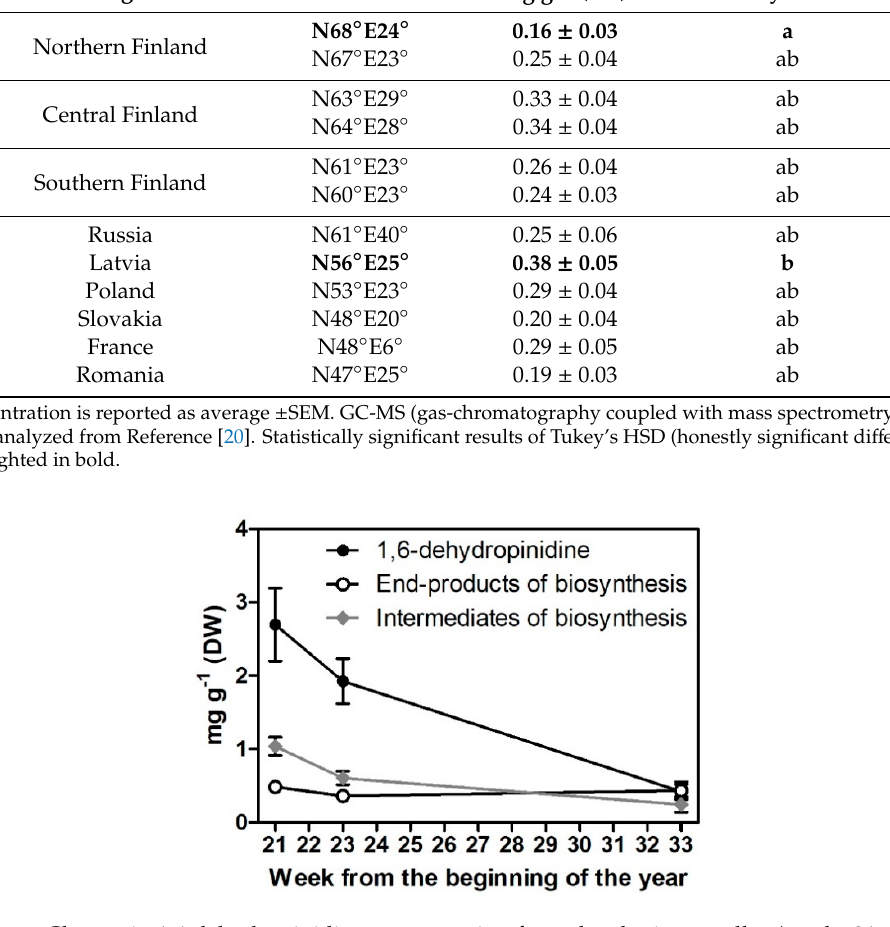
Figure 2. Change in 1,6-dehydropinidine concentration from developing needles (weeks 21–23) to mature needles (week 33). Data for intermediates and end-products of piperidine alkaloid biosynthesis are from Reference [12]. Here, cis -pinidinol is considered an end-product of biosynthesis because detectible amounts of cis -pinidine were not recorded.